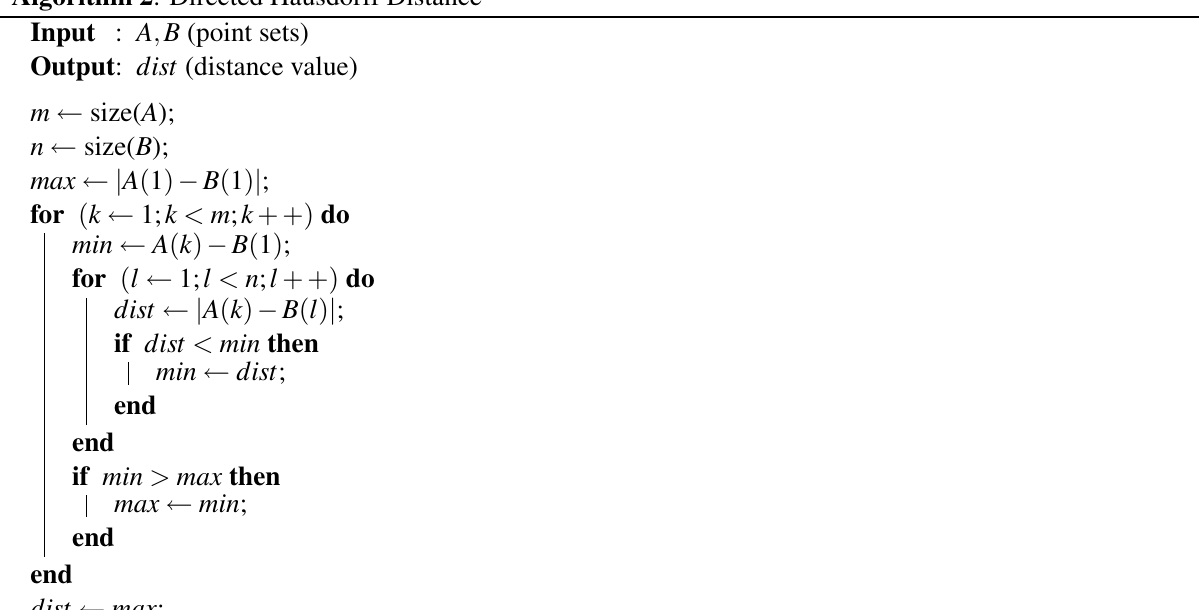
Algorithm 2 : Directed Hausdorff